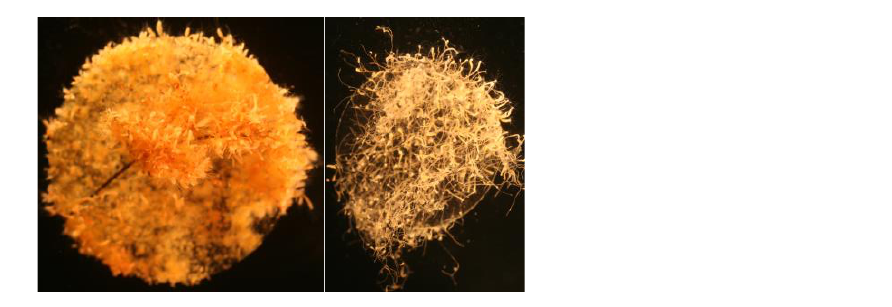
Figure 2. Colonies of polyps of Podocoryna carnea (left) and Eirene sp. growing on 18 mm diameter cover glass under nutrient-abundant conditions.